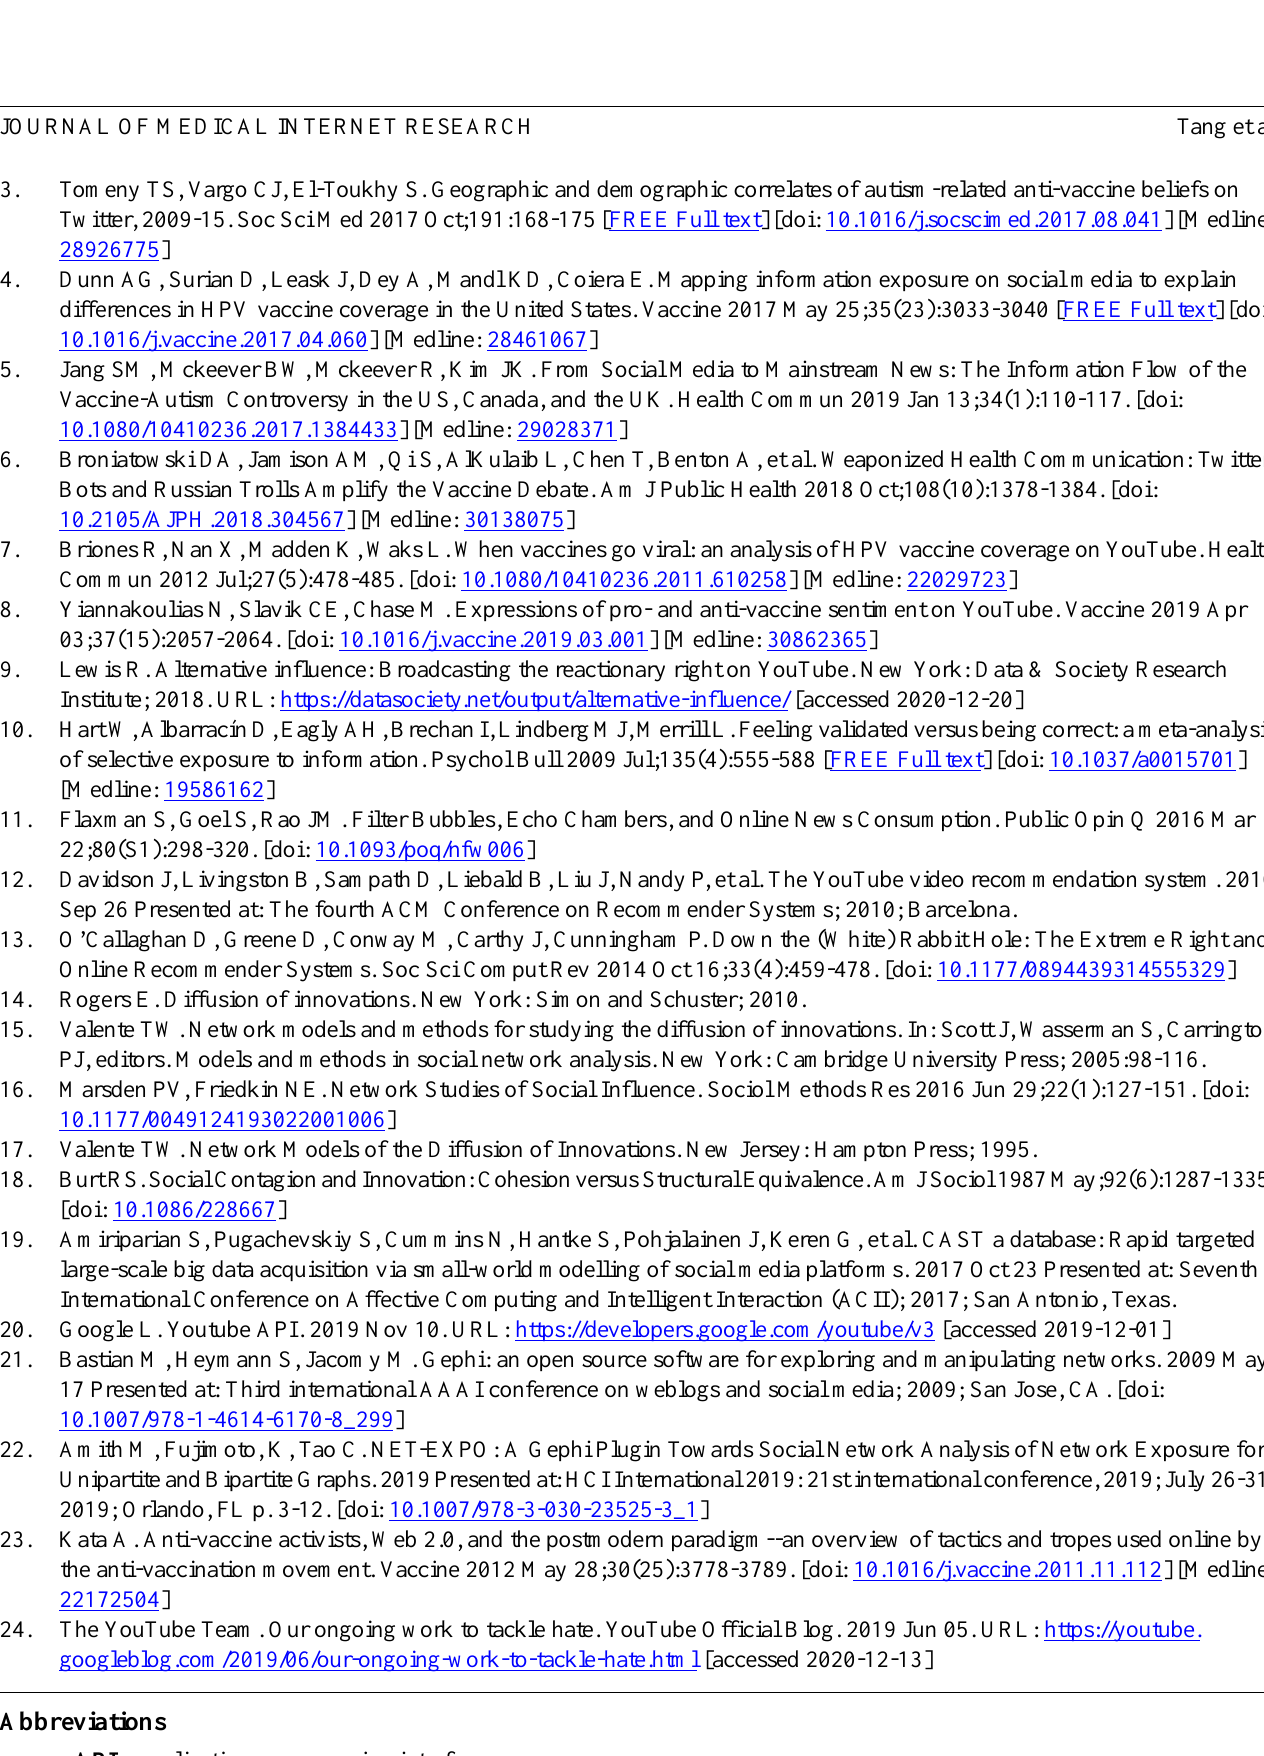
API: application programming interface NEM: network exposure